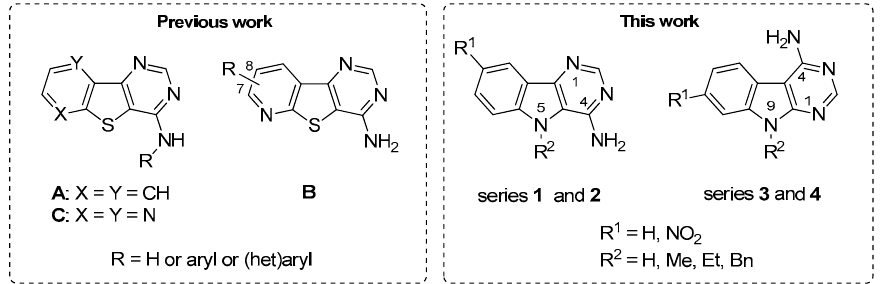
Figure 1. Previous benzo[ b ]thieno[3,2- d ]pyrimidin-4-amines ( A ) and their pyrido ( B ) and pyrazino ( C ) analogues (left). The 9 H -pyrimido[5,4- b ]indol-4-amine derivatives ( 1 and 2 ) and their 9 H pyrimido[4,5- b ]indole isomers ( 3 and 4 ) described in this work (right).